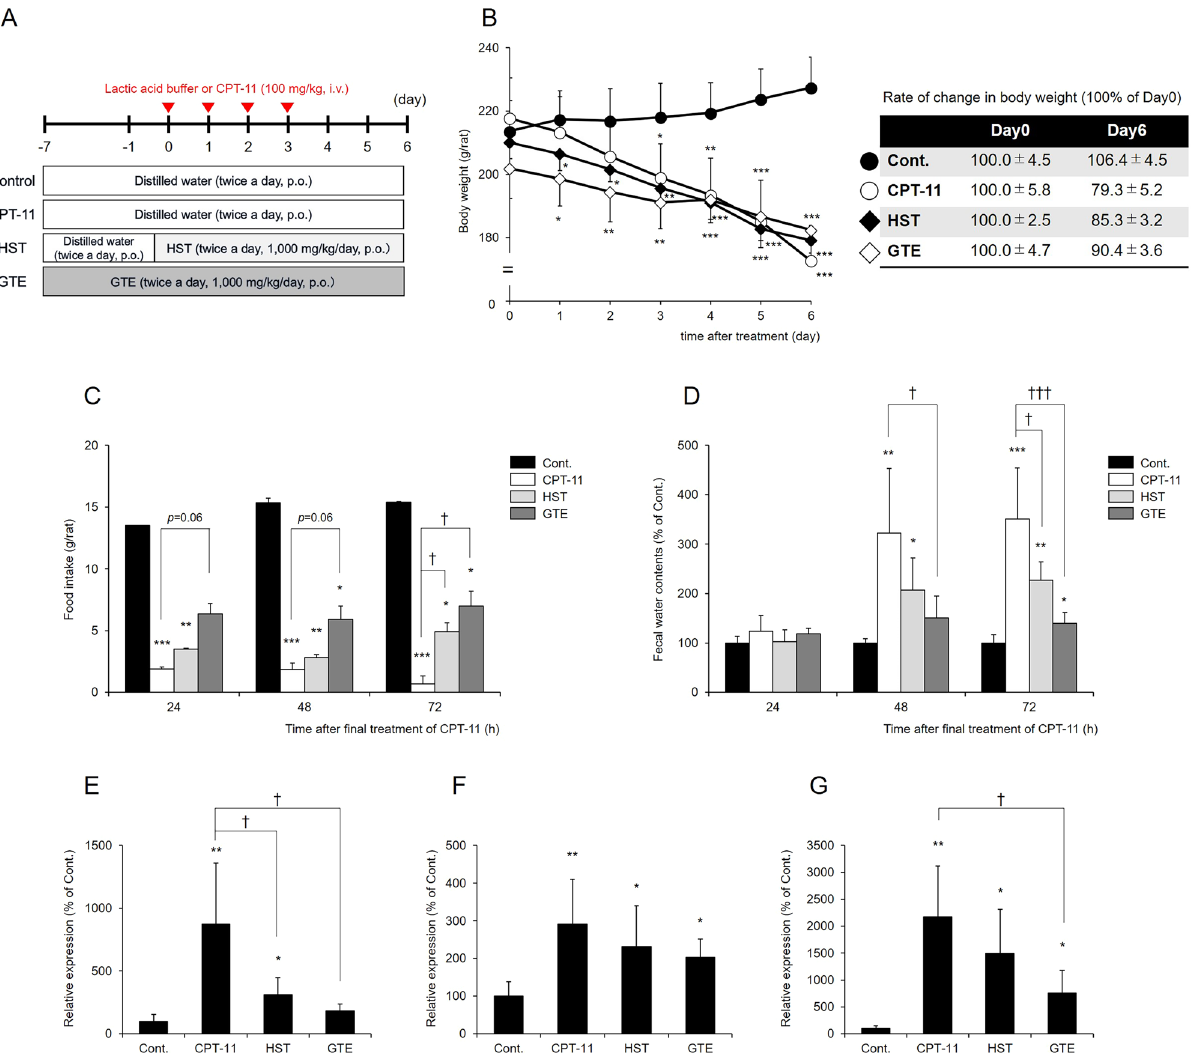
Figure 1. Effects of GTE on CPT-11-induced delayed diarrhea. Rats were administered CPT-11 or lactic acid buffer intravenously for 4 days, and HST or GTE was administered in combination ( A ). Body weight ( B ), 24-h food intake ( C ), and fecal water content ( D ) were measured. The water content in feces is shown as 100% of the mean value in the control group. The mRNA levels of IL-6 ( E ), IL-1β ( F ), and iNOS ( G ) in the colon were measured by real-time PCR. The levels of each gene were normalized using β-actin levels and are shown as 100% of the mean value in the control group (mean ± S.D., n = 5, * p < 0.05, ** p < 0.01, *** p < 0.001 vs. Cont., † p < 0.05, ††† p < 0.001 vs.